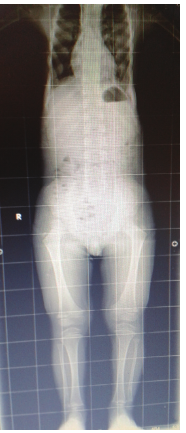
Figure 2: Radiography of patient. A long and narrow thorax, short and horizontal costae, and short